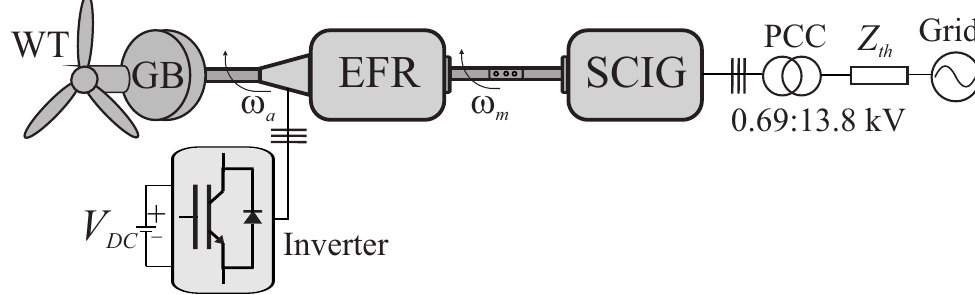
Figure 1. SCIG grid-connected driven by an Electromagnetic Frequency Regulator